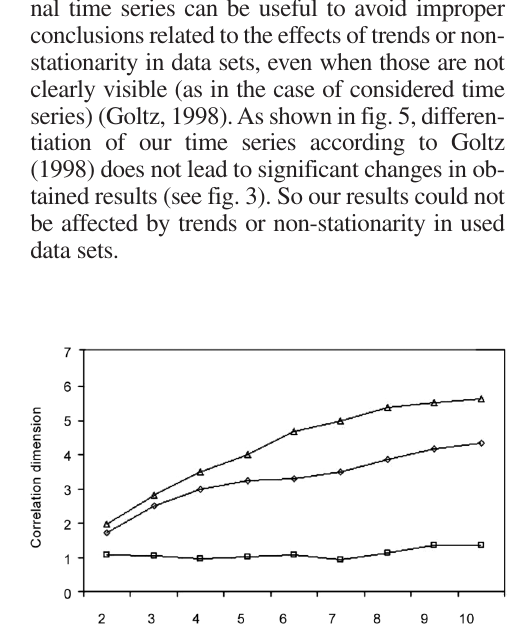
Fig. 3. Correlation dimension versus embedding di- mension of waiting times sequences (complete cata- logue): asterisks – integral time series (1975-1996); circles – before beginning of experiment (1975-1983); squares – during experiments (1983-1988); triangles – after experiments (1988-1992); diamonds correspond to random number sequence.